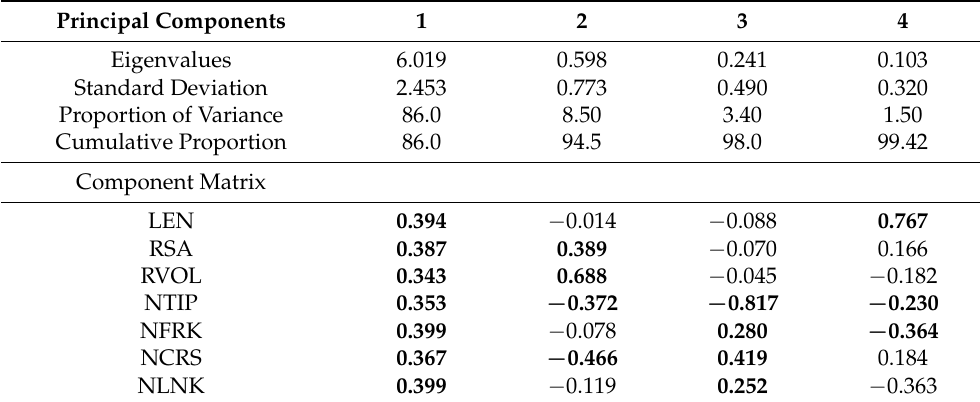
Table 2. Eigenvalues and percentage of total variation and component matrix for the first four principal component axes of seven root traits of seedlings of 267 Andean common bean genotypes grown under the control treatment.